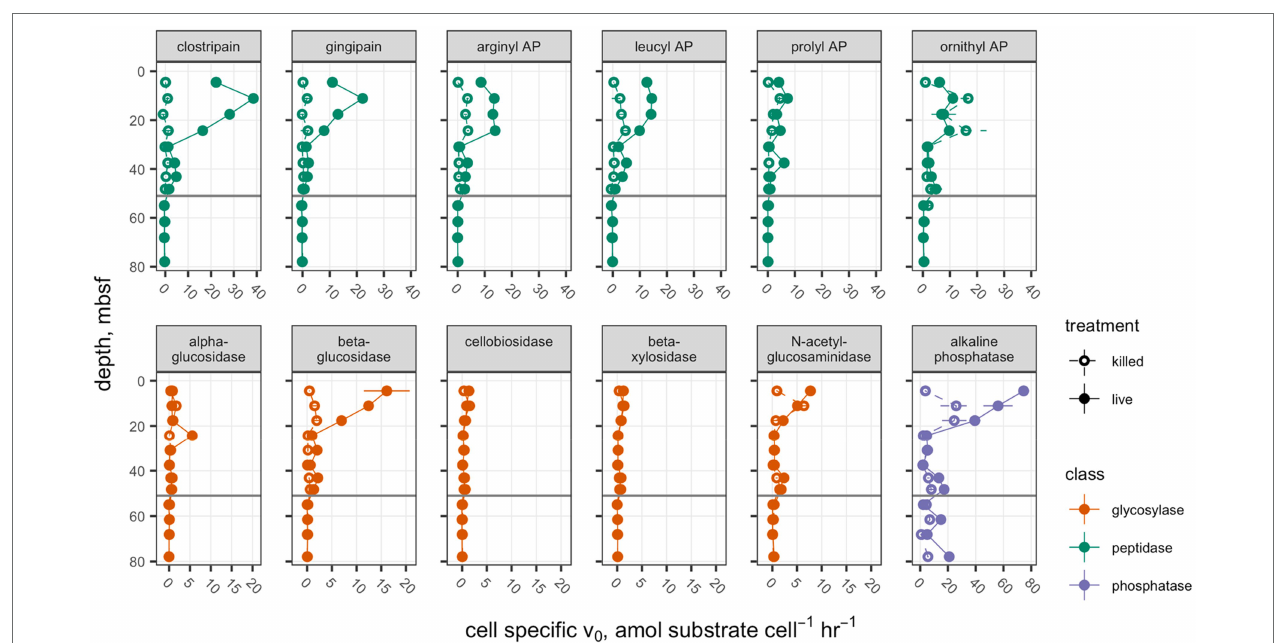
FIGURE 3 | Cell-specific potential enzyme activities. Presentation is the same as Figure 1